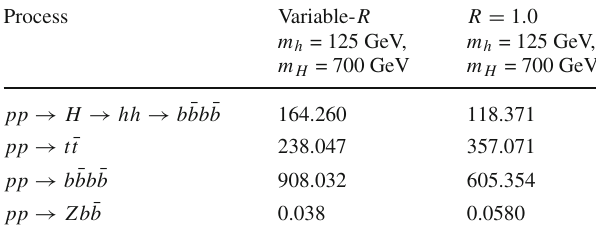
Table 7 Event rates of signal and backgrounds for L = 300 fb − 1 upon enforcing the initial cuts plus the mass selection criteria of Fig. 8 for the two jet reconstruction procedures Process